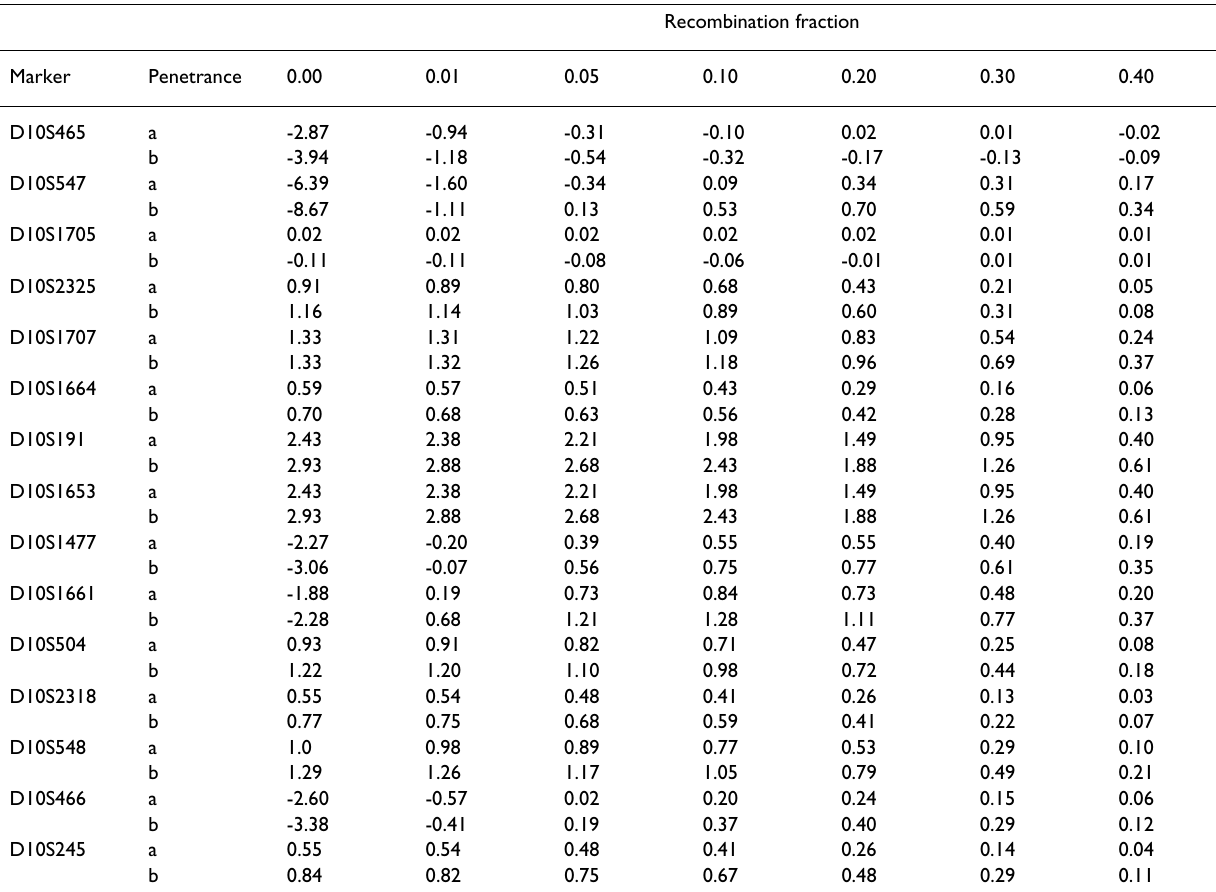
Table 3: Two-point lod scores obtained for 15 markers on chromosome 10 in the South African family with recurrence of arrhythmogenic right ventricular cardiomyopathy. Lod scores were calculated for different values of penetrance (a: 60%; b: 95%)